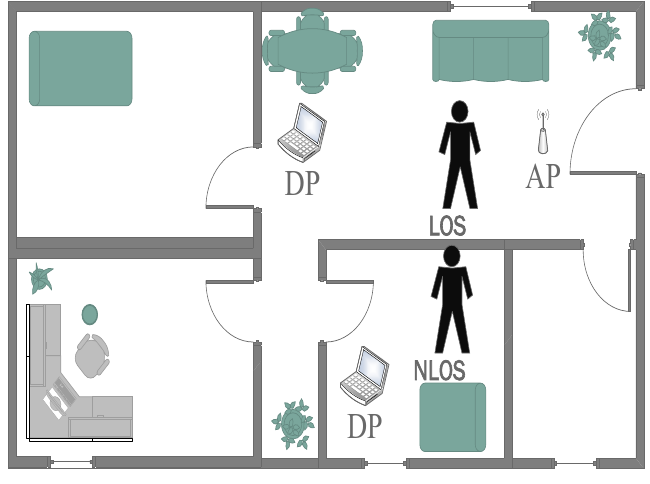
Figure 5. Floor plan of the experiment environment.